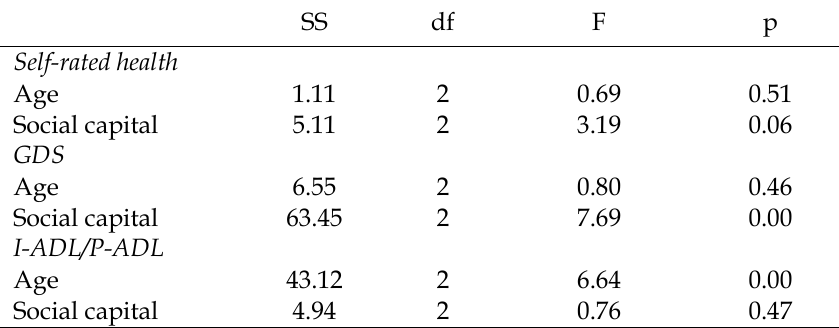
Table 6. Univariate ANOVAs of self-rated health, GDS and I-ADL/P- ADL by age and social capital SS df F p Self-rated health Age 1.11 2 0.69 0.51 Social capital 5.11 2 3.19 0.06 GDS Age 6.55 0.80